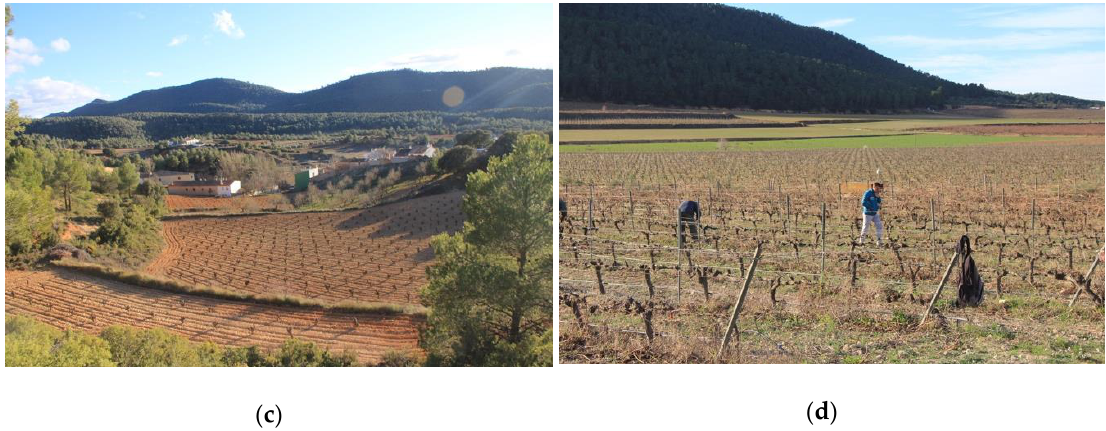
Figure 8 . Sediment collected at the bottom of the slope after a thunderstorm in September 2018 in a vineyard in Fontanars dels Alforins ( a ) and in a young vineyard in Font de la Figuera ( b ). ( c ), recent vineyards landscape in Requena; ( d ), recent organic wine farming in Moixent.